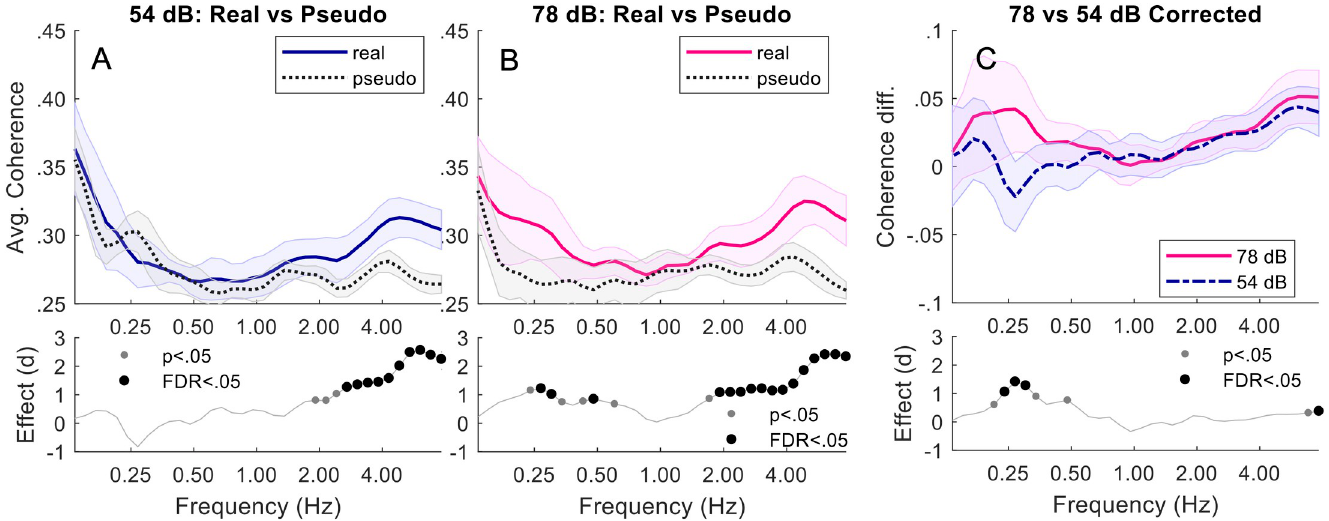
Fig 3. Triads in speech-shaped noise. Top plots of (A) and (B) show the average wavelet coherence responses for Real vs Pseudo during 54 dB and 78 dB respectively. The mean coherence over all triads (with standard error) is shown across a range of frequencies. The lower plots show the corresponding Pseudo-Real effect size (Cohen’s d), with both significance and FDR-adjusted significance. (C) shows the corrected (baseline removed) coherence difference between 78 and 54 dB.